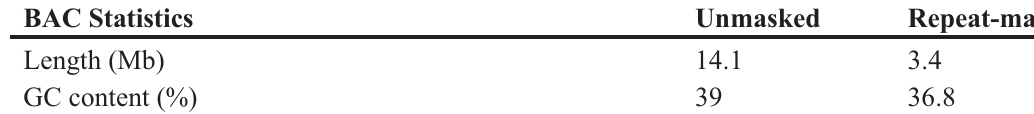
Table 3. AUGUSTUS [65] predicted genes and their genic features in the sunflower genome. Both the repeat-masked and the unmasked datasets were used with the following parameters: Alternative scripts = none, Allowed gene structures = only predict complete genes; Training set = Arabidopsis thaliana